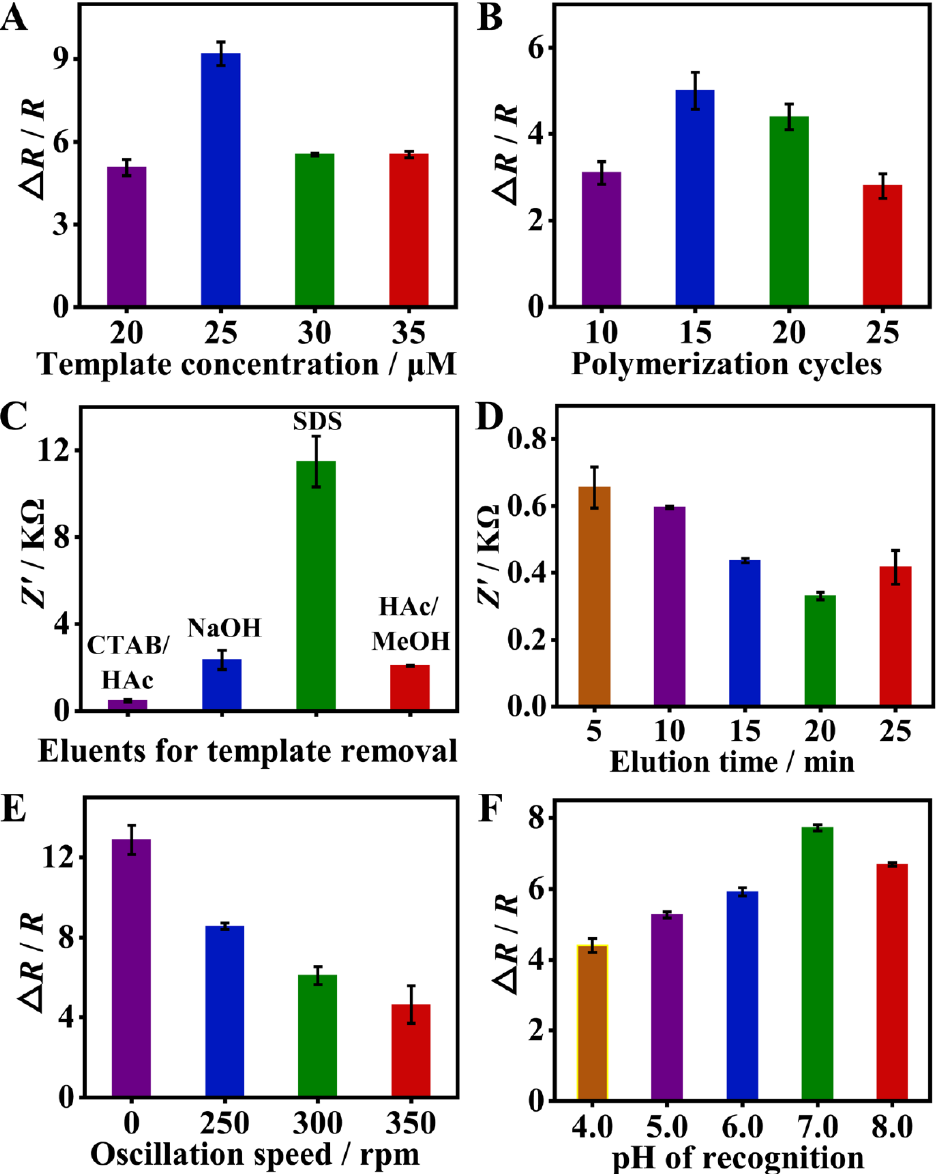
Figure 4. Optimization of experimental conditions, including template concentration ( A ), polymer- ization cycles ( B ), eluents and elution time for template removal ( C , D ), and oscillation speed and pH during recognition ( E , F ), to obtain a better sensing performance toward SMZ. Firstly, the eluent was optimized and determined by polymerization of 10 cycles at a concentration of 35 μM SMZ. Then, the concentration of SMZ was optimized in the case of polymerization of 10 cycles. Finally, the number of polymerization cycles was optimized at a template concentration of 25 μM. The rest are optimized in turn.